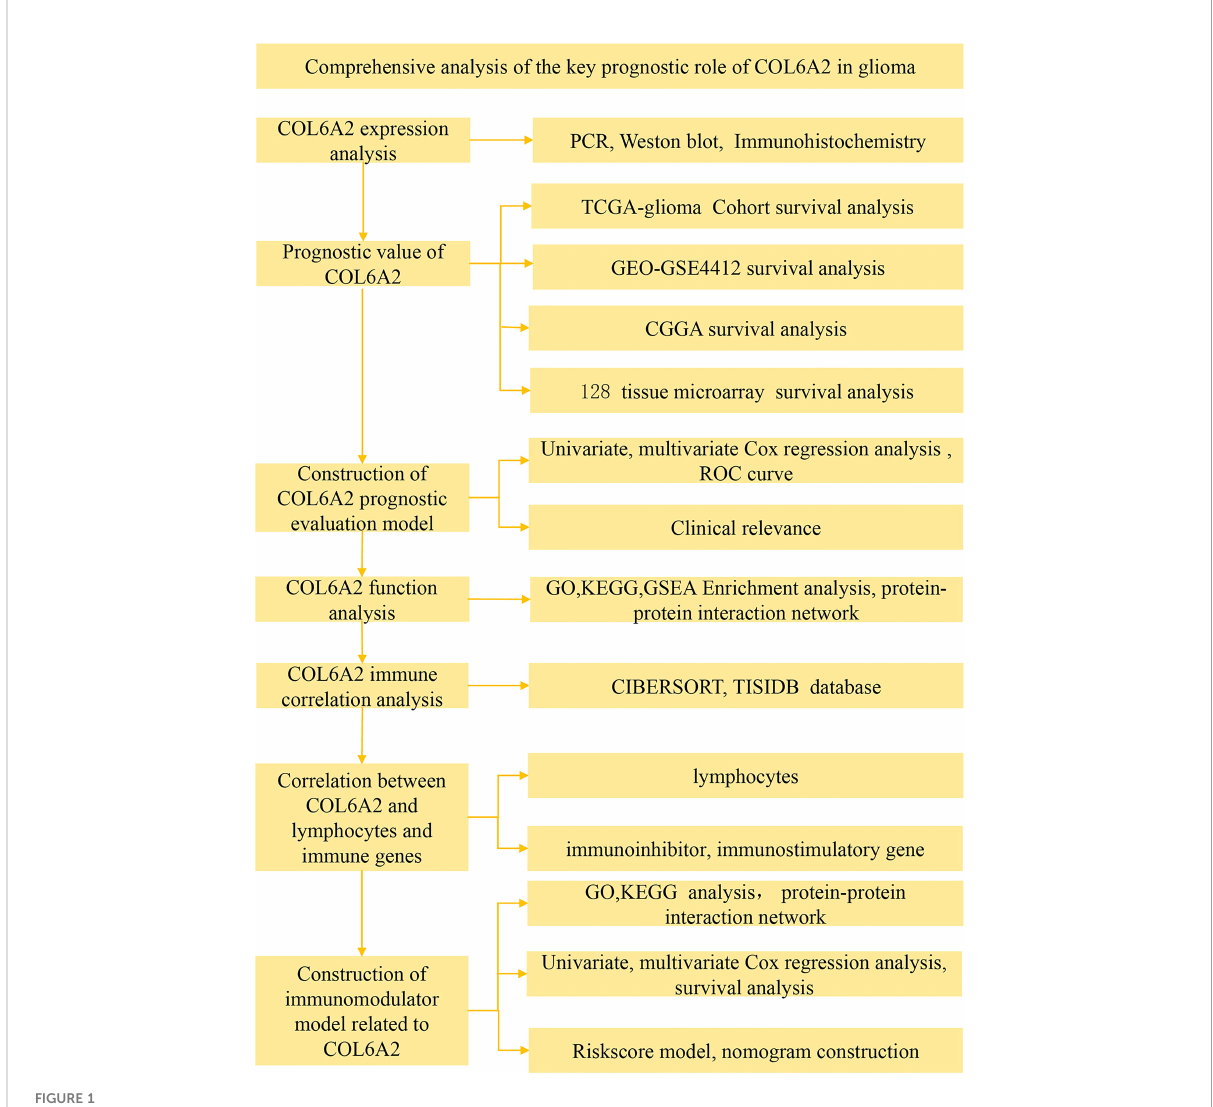
FIGURE 1 Flow chart of data collection and analysis COL6A2 expression in